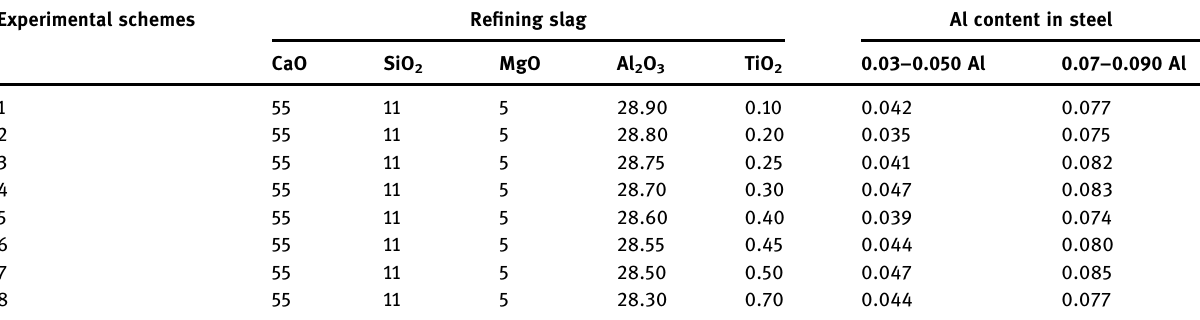
Table 4: The component of re fi ning slag with di ff erent TiO 2 and Al content in steel, % Experimental schemes